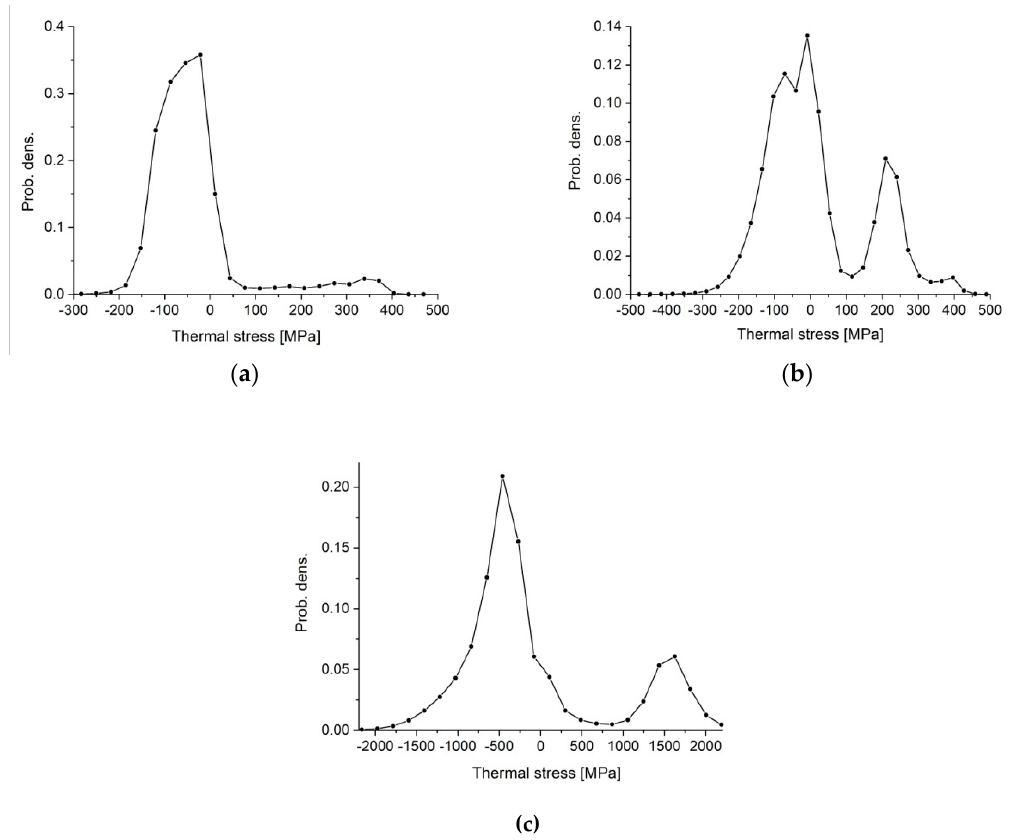
Figure 6. Histograms of residual stresses determined by FEM simulation for ( a ) Si 3 N 4 , ( b ) Si 3 N 4 + SiC, and ( c ) Si 3 N 4 + TiN.